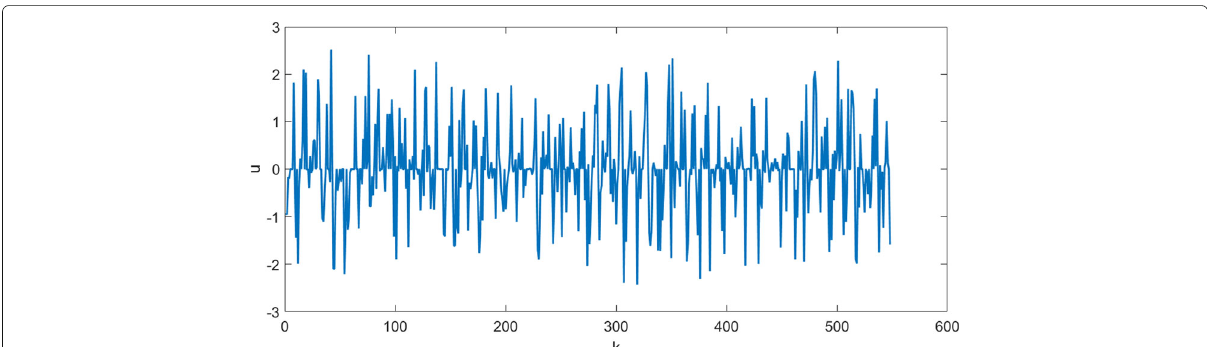
Fig. 2 u ( k ) for a burst length of 500 symbols, modulation type = BPSK, η = 0.1, SNR = 10 dB. CS leads to burst of error occurrence due to the symbol insertion